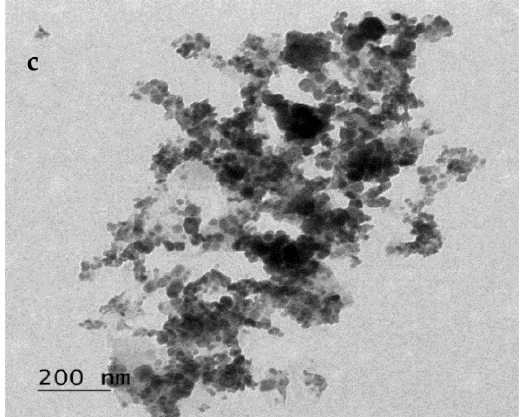
Figure 2. The structural and morphological characteristics of the ION-RGO nanocomposite: ( a ) XRD diffractogram; ( b ) Raman spectrum where ION and RGO phases are readily detected; ( c ) TEM image of the nanocomposite where the RGO sheet is decorated with spherical-like